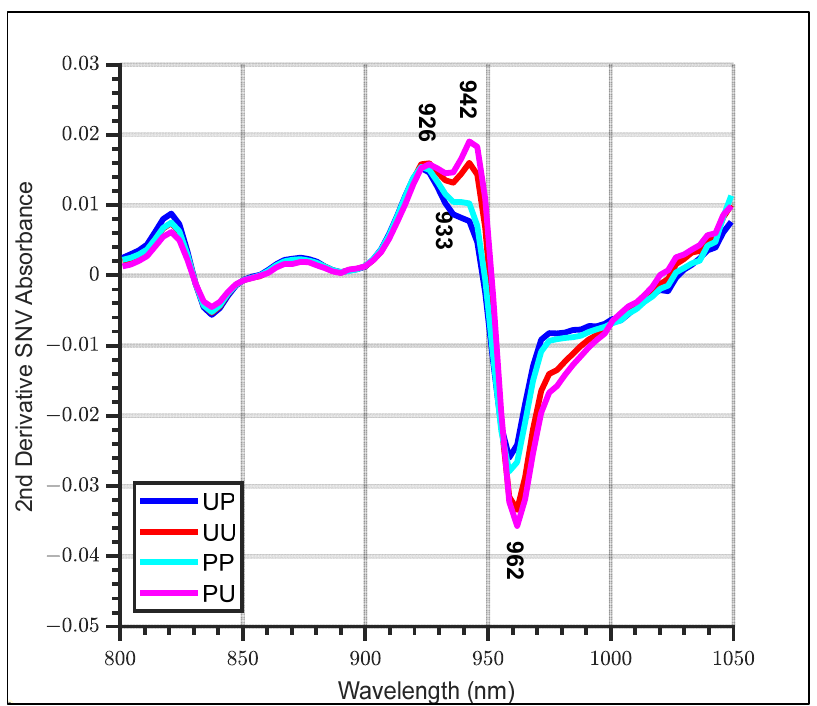
Figure 4. Standard Normal Variate (SNV) + 2D absorbance for each configuration (Blue—Unpeeled Polarized, Red—Unpeeled Unpolarized, Cyan—Peeled Polarized and Magenta—Peeled Unpolarized kiwifruit) in the range of 800–1050 nm.